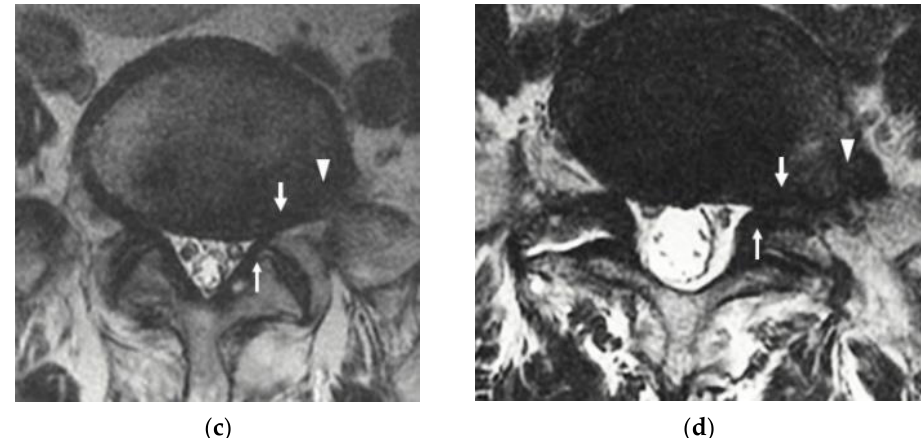
Figure 1. Illustration of the surgical approach for the coexisting intra-and-extraspinal root compression lesions at the L5-S1 level. ( a ) The surgical route of interlaminar contralateral endoscopic lumbar foraminotomy (ICELF) on a lumbar spinal model. The black line showed the skin incision point. ( b ) The trajectory of ICELF on the axial plane. Lateral recess decompression and medial foraminal opening were performed with an initial approaching trajectory (long blue triangle. The trajectory was then changed to a lower angle by levering the endoscope (long red triangle) to reach the foraminal and extraforaminal space. ( c , d ) Multifocal nerve root compression lesions at the intra-and-extra spinal canal are shown on the magnetic resonance imaging at the lateral recess (thin arrows), foraminal region (broad arrows), and extraforaminal region (arrowheads). All the indicated lesions could be resolved with one direction approach.